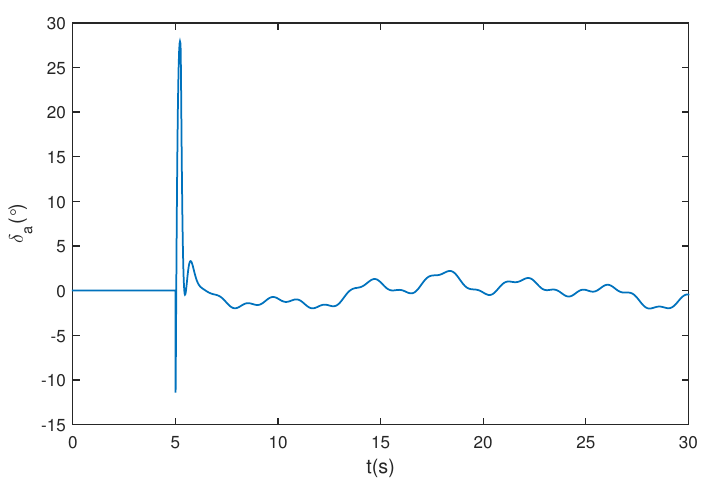
Figure 13. The aileron deflection angle output in attitude tracking.